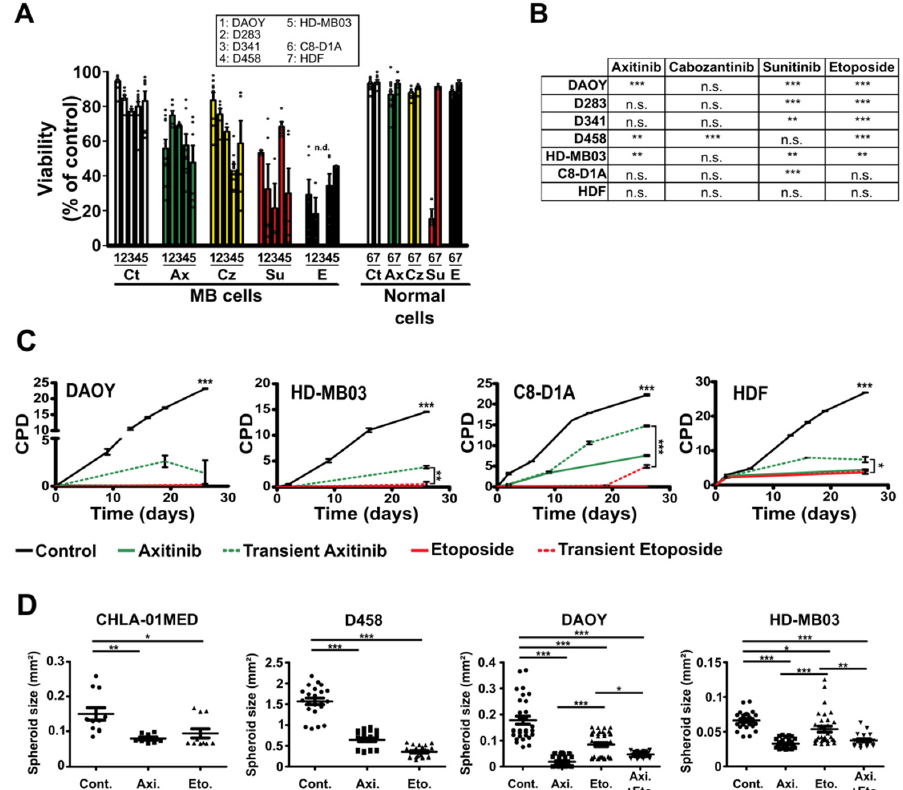
Figure 1. Antiangiogenic compounds strongly impair the viability and proliferation of MB cells. ( A ) Viability of the indicated cell lines treated for 48 h with axitinib (5 µM, Ax, green), cabozantinib (5 µM, Cz, yellow), sunitinib (5 µM, Su, red) or etoposide (1 µM, E, black). All the compounds were